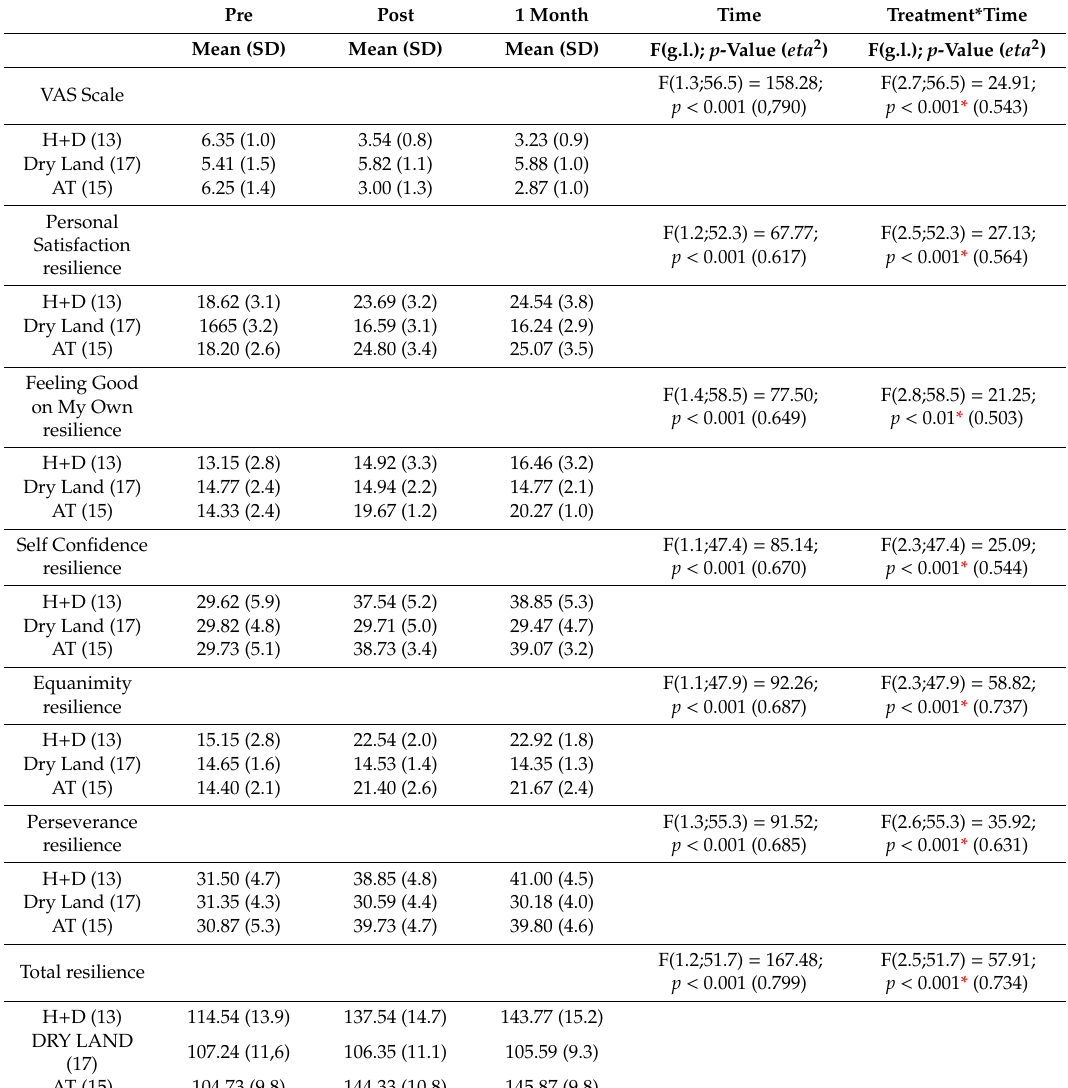
Table 1. Values obtained on the VAS and resilience